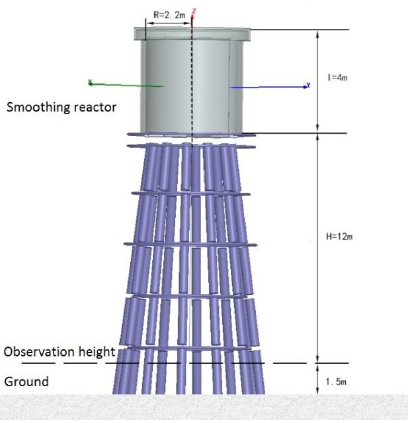
Figure 6. The reactor height l is 4 m, the radius R is 2.2 m, the observation height is 1.5 m from the ground, and the distance between the erection position and the observation height H is 12 m.